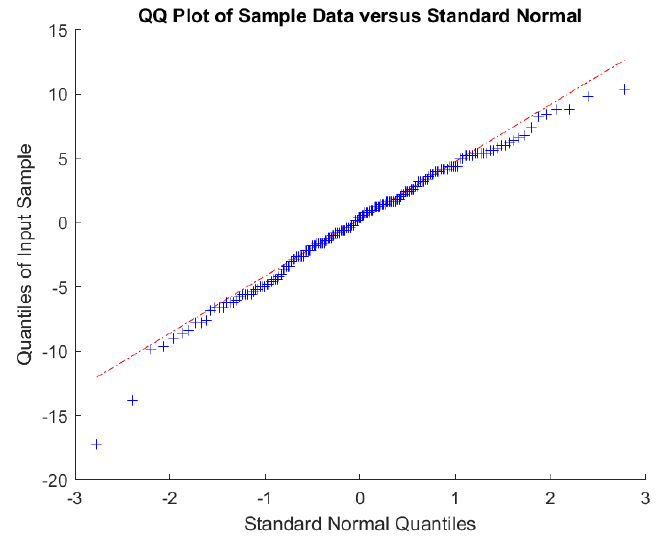
Figure 6. Q–Q plot of variation and normal